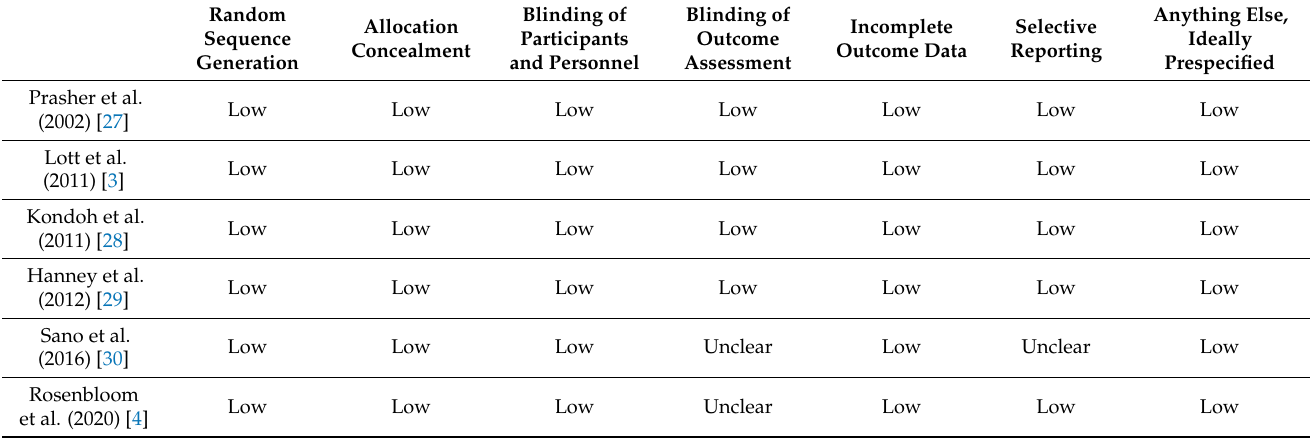
Table 2. Risk of